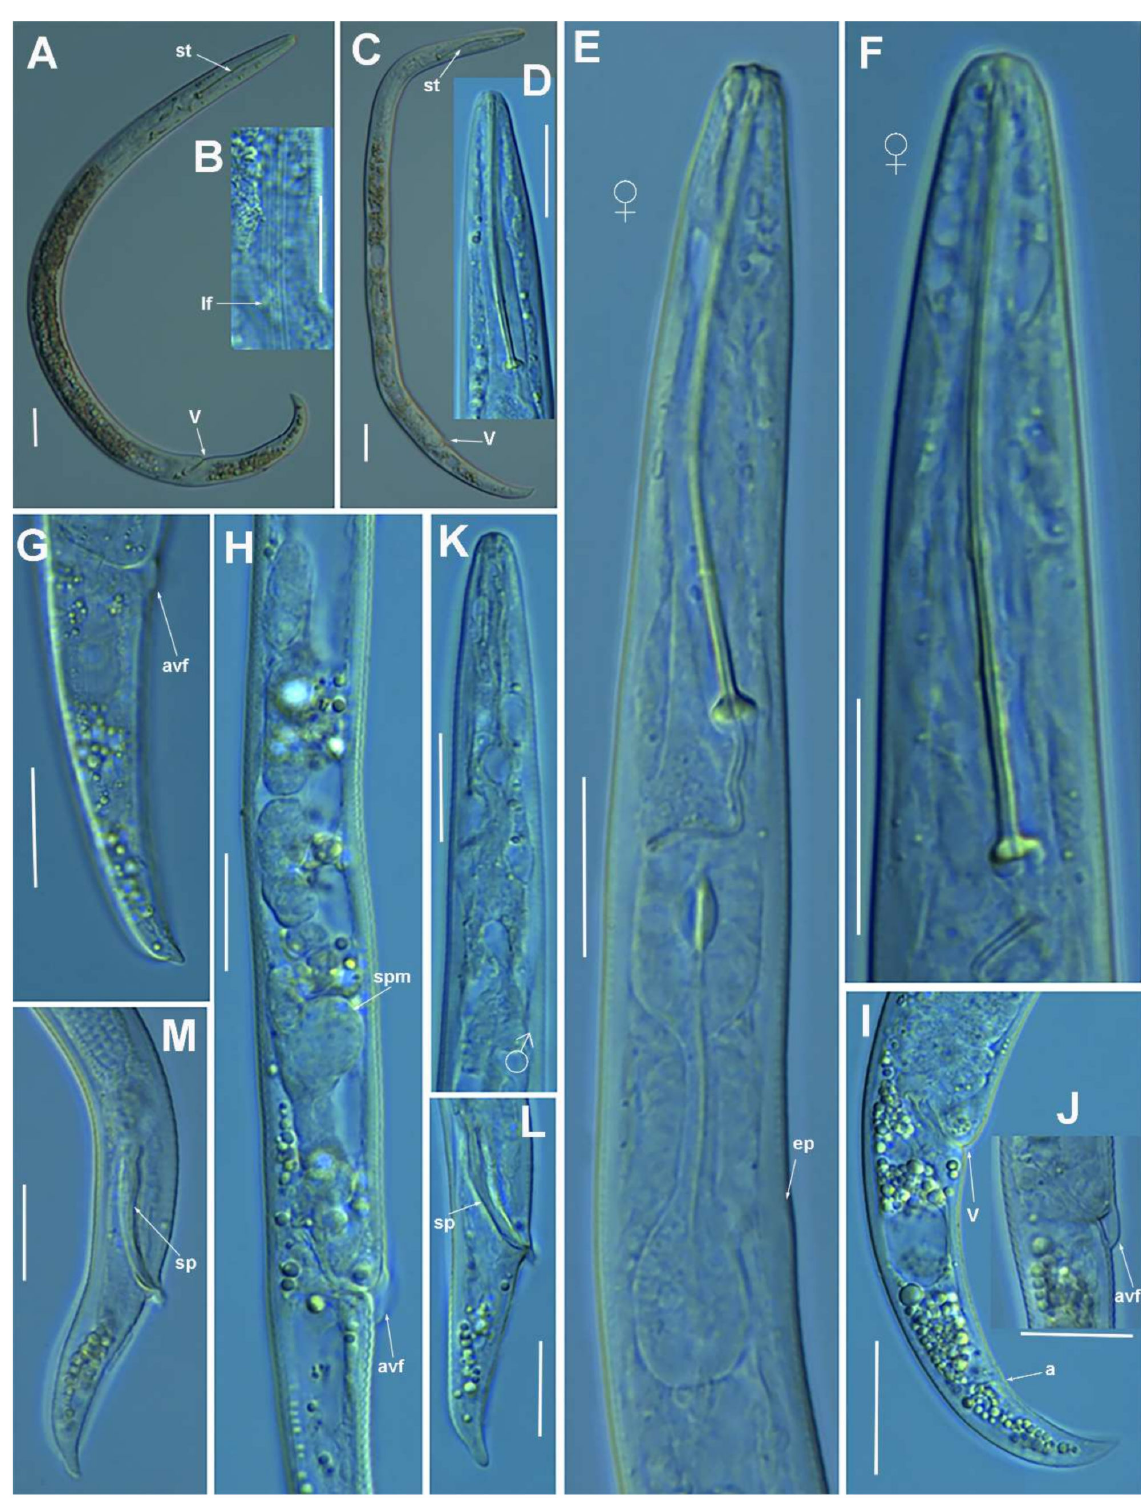
Figure 2. Light photomicrographs of Paratylenchus parastraeleni sp. nov. female and male. ( A , C ) Entire female with vulva arrowed; ( B ) detail of lateral fields; ( D , F ) detail of female stylet region; ( E ) female pharyngeal region; ( G – J ) female posterior region with vulva and anus (arrowed) and detail of vulva showing advulval flap (arrowed); ( K ) male pharyngeal region showing absence of stylet; ( L , M ) male posterior region showing spicules (arrowed). Scale bars ( A – M = 20 µ m). (Abbreviations: a = anus; avf = advulval flap; ep = excretory pore; lf = lateral field; sp = spicules; spm = spermatheca; V =